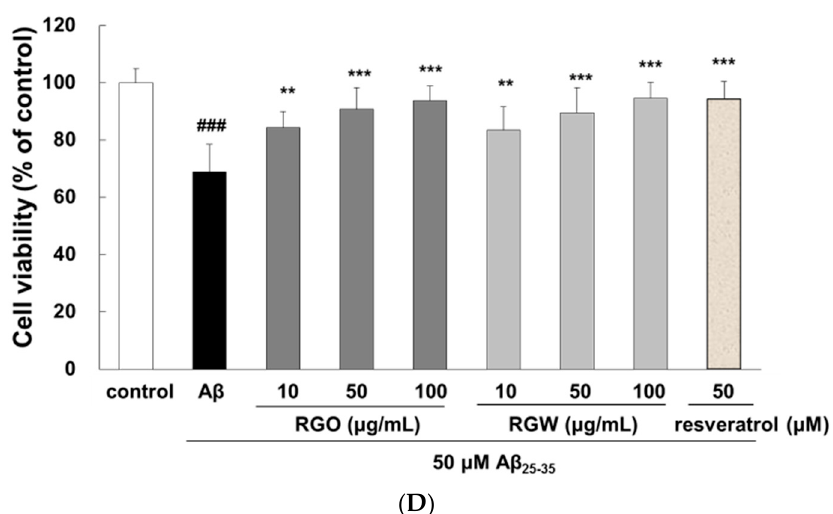
Figure 1. Red ginseng oil (RGO) and red ginseng water (RGW) protected A β 25–35 -stimulated cellular death. Assessment of cytotoxicity of RGO or RGW alone in PC12 cells ( A ). PC12 cells were treated with RGO or RGW for 1 h followed by exposure to 50 µ M A β 25–35 for 24 h, and cell viability was detected by 3-(4,5-dimethylthiazol-2-yl)-2,5-diphenyltetrazolium bromide (MTT) reduction assay ( B ) and flow cytometry ( C ). Statistical analysis results of the percentage of cell viability by flow cytometry ( D ). ### p < 0.001 compared to control group; *** p < 0.001 and ** p < 0.01 compared to A β 25–35 alone (ANOVA followed by Duncan’s multiple comparison test). Resveratrol was used as a positive control.